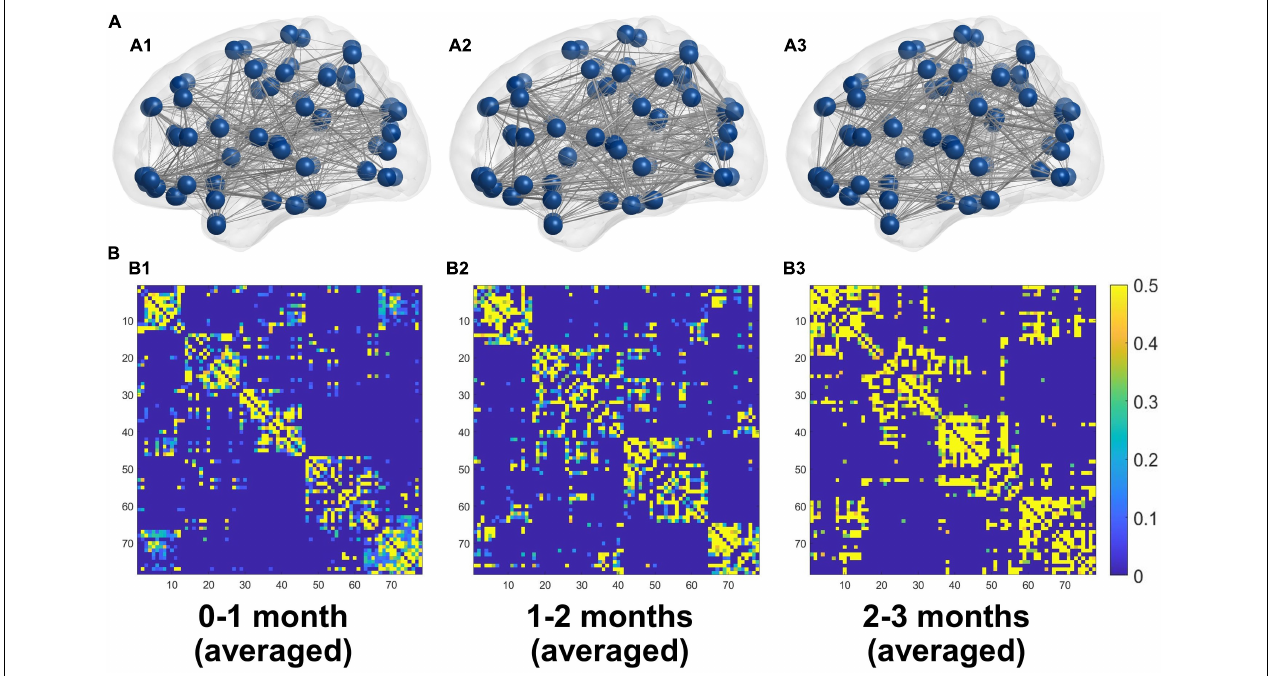
FIGURE 3 | (A) 3D representations of the mean structural networks of 0–1 (A1), 1–2 (A2), and 2–3 (A3) months groups. (B) The averaged structural connectivity matrices of 0–1 (B1), 1–2 (B2), and 2–3 (B3) months groups.